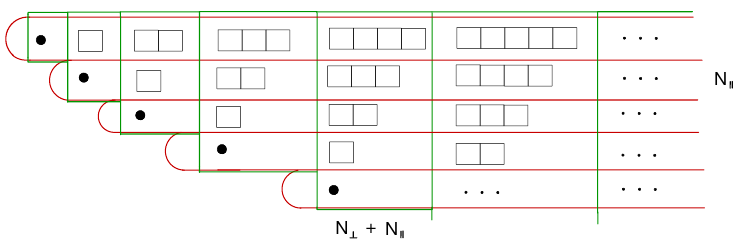
Figure 2 . The so (1 ; 1)-covariant basis of hs [ (cid:21) ] in the canonical and twisted forms. Each Young diagram of length k stands for a rank- k traceless so (1 ; 1)-tensor module d k . Subspaces are W n shown in red horizontal contours. The counting operator N has a (cid:12)xed eigenvalue on all elements k inside a given red contour. The so (2 ; 1)-modules are shown in green vertical contours. The D n counting operator N = N ? + N has a (cid:12)xed eigenvalue on all elements inside a given green contour. k show that the so (2 ; 1)-modules in (5.28) are isomorphic to Verma modules W n V (cid:1) n